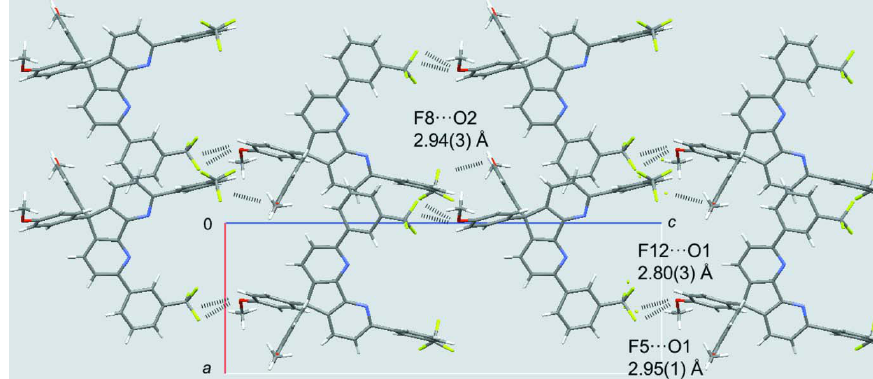
Figure 3 The packing diagram of